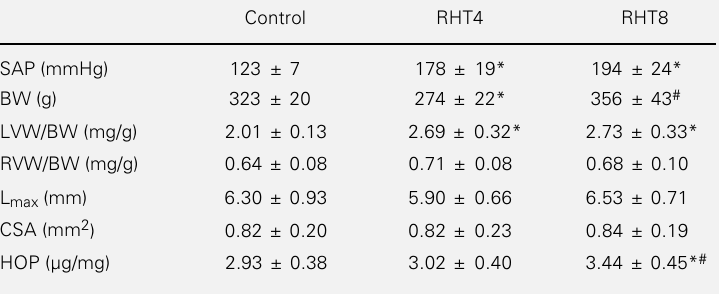
Table 1 - Group comparisons of systolic arterial pressure (SAP), morphometric param- eters and myocardial hydroxyproline concentration (HOP). Data are reported as means ± SD for N = 15. BW, Body weight; LVW, left ventricle weight; RVW, right ventricle weight; L max , muscle length at peak of developed tension; CSA, cross-sectional area; RHT4, renovascular hypertension for 4 weeks; RHT8, renovascular hypertension for 8 weeks. *P<0.05 vs control group; # P<0.05 vs RHT4 group (one-way analysis of variance and post hoc Tukey test).